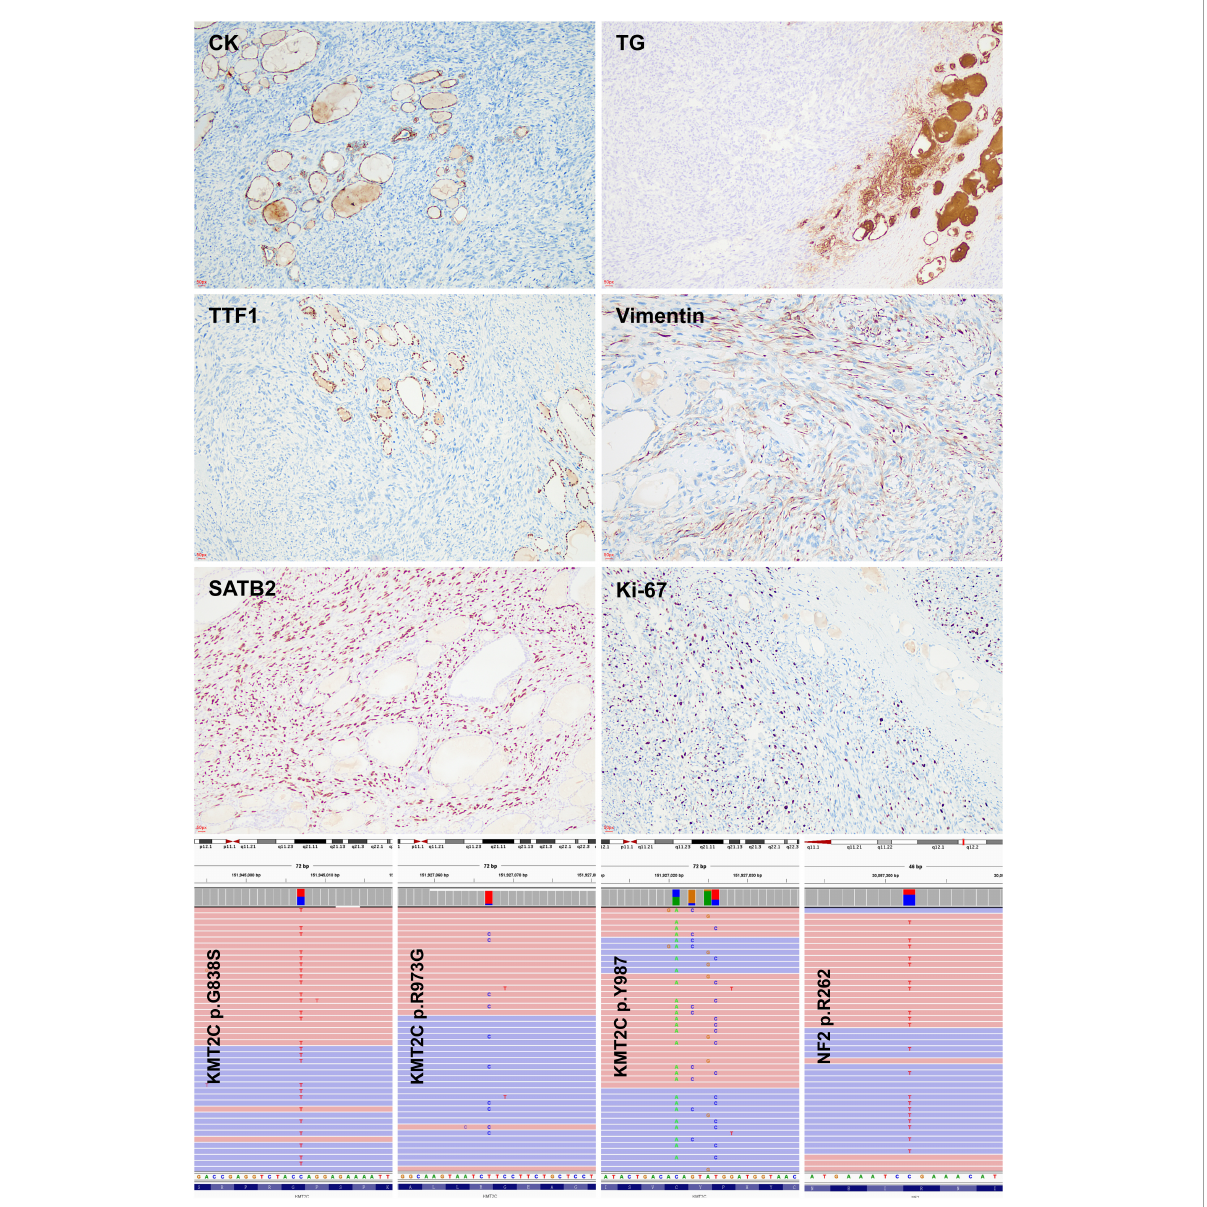
FIGURE2 Immunohistochemical and molecular features of thyroid osteosarcoma. Negative immunoreaction with cytokeratin, thyroglobulin, and TTF-1 indicated the non-thyroid follicular origination of the tumour. Positive immunoreaction with SATB-2 and low ki67 labeling index suggested the diagnosis of osteosarcoma. KMT2C mutations were detected by targeted next generation